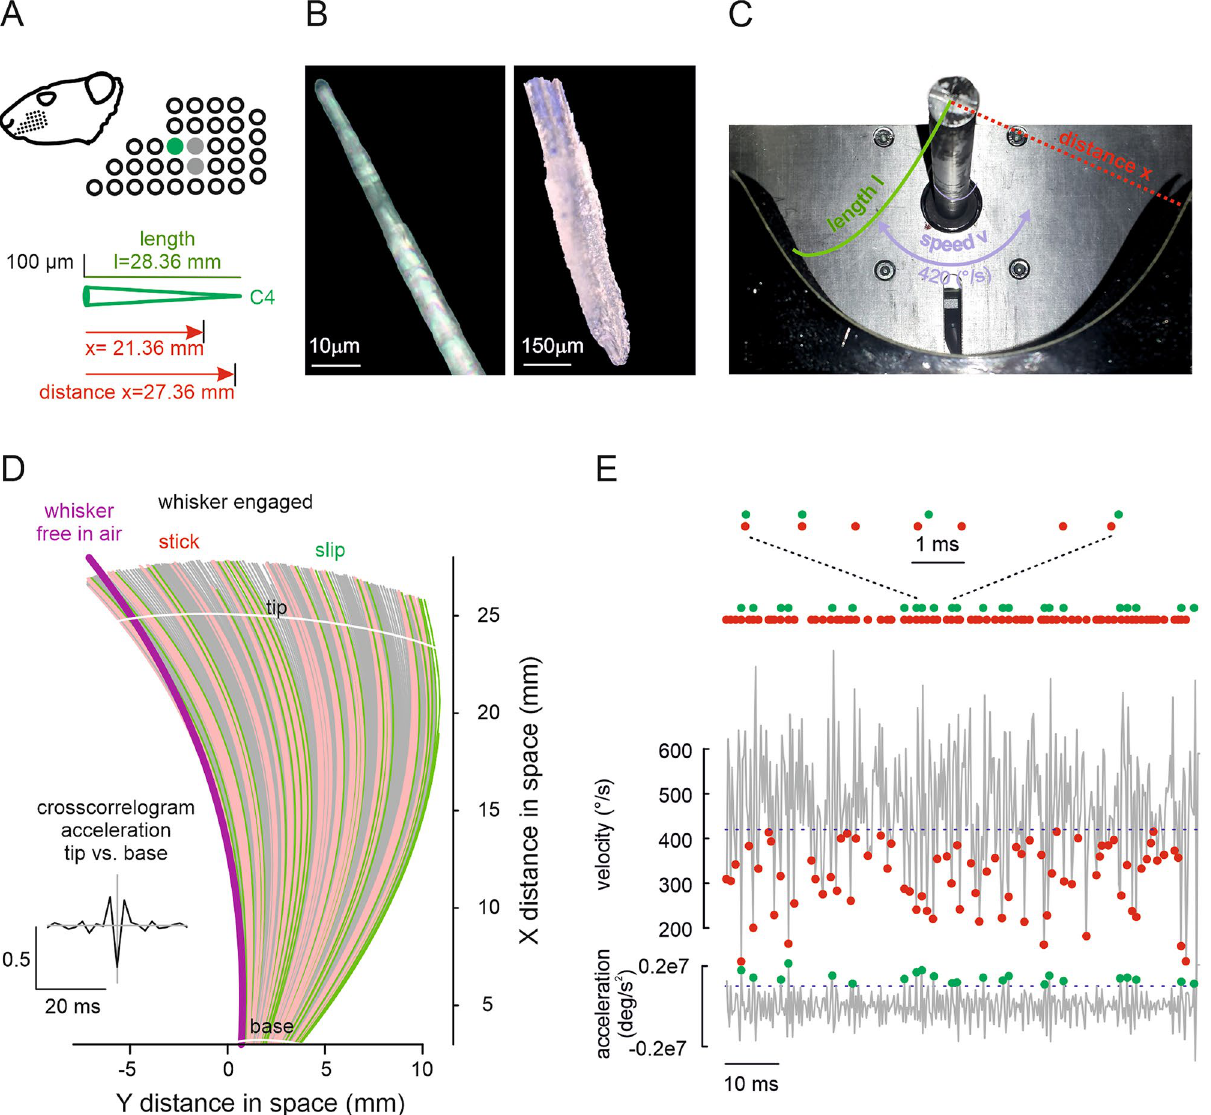
Figure 1. Whisker and biomechanical measurement. ( A ) Rat whisker C4. The rat ‘s head and location of whisker field is shown. The position of C4 is the green dot in the magnified whisker field. Conical shape, length l and distance x (cf. panel C) are shown. (Note that we repeated core measurements using also a C3 and a D3 whisker, the locations of which are indicated by grey dots) ( B ) Microscopic images of whisker tip (left) and base (right). ( C ) Experimental set up (view from the recording camera). The rotating rod is seen on top. At the bottom, the half-cylinder holding the sandpaper is shown. Experimental variables position on whisker (length) l , driving speed v , and distance x are indicated. ( D ) Stick–slip events in a whisker moving across a texture. Videographic analysis of whisker shape and location in x and y during one protraction (all frames of the video 27.36 mm). Red: are shown, the sandpaper was located at distance 1 mm less than whisker length: i.e. at x = all frames below the driving velocity—pointing to sticking periods. Green: instances with local maximum of acceleration—pointing to slips. The first frame captured when the whisker was moving free in air (no texture) 24 mm, top white is shown for comparison (violet). Inset: Cross-correlogram of accelerations at the tip ( x = 3 mm, bottom white line). The grey lines indicate time lag t 0 (abscissa) and line) vs. that at the base ( x = = 0 (ordinate). ( E ) Method to identify stick and slip events. Sticks (red) were found by correlation coefficient r = thresholding the velocity trace (at driving speed 420°/s) and minimizing the trace below that limit. Slips (green) were found by maximizing the acceleration strips above threshold (2 standard deviations found with movement in air/no contact). On top all events are shown again aligned on the time axis. Further, a short sequence of 4 slips and 7 sticks is shown in the